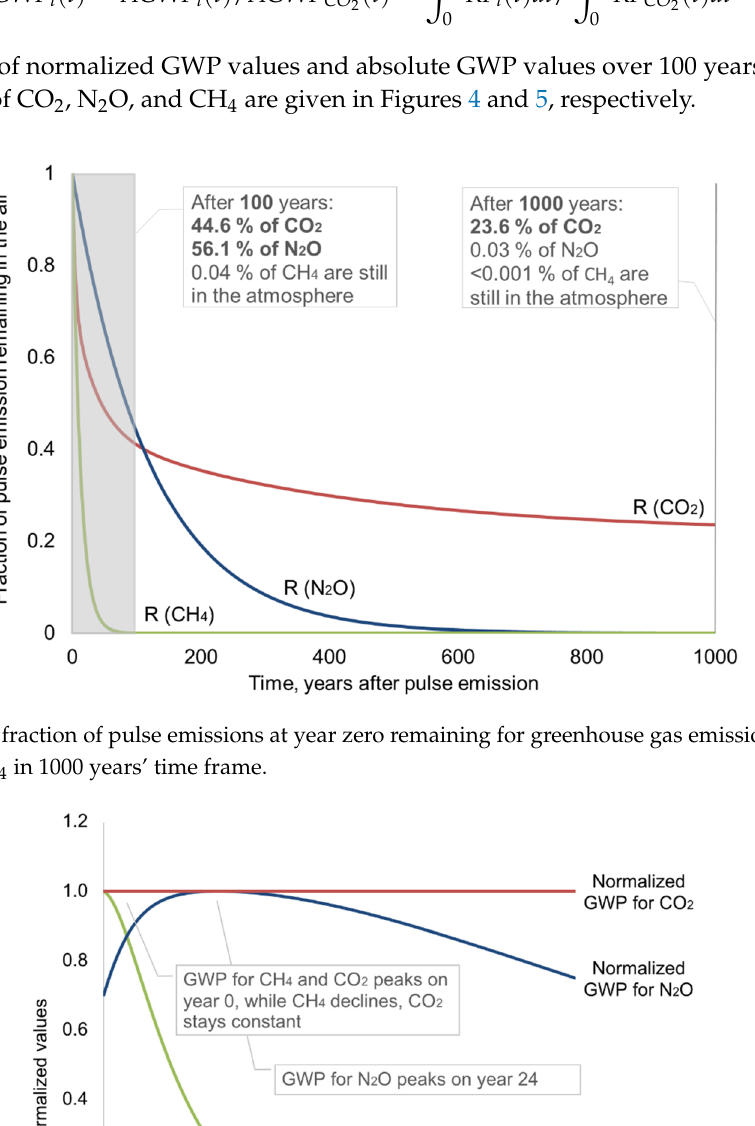
Figure 5. Absolute GWP values as a response to emission of CO 2 , N 2 O, and CH 4 at year zero, unitless. As can be seen in Figures 4 and 5, the trendlines for the emissions of CH 4 and N 2 O are both of different natures and different magnitude, while CO 2 constant values of 1 are assumed. Global temperature potential for pollutant i at time t ( GTP i ( t )) is calculated by referring absolute global temperature potential of the pollutant i ( AGTPi ), to the AGTP of the reference gas, usually CO 2 , and integrating it over time period t : (cid:1833)(cid:1846)(cid:1842) (cid:3036) ((cid:1872)) = (cid:1827)(cid:1833)(cid:1846)(cid:1842) (cid:3036) ((cid:1872)) (cid:1827)(cid:1833)(cid:1846)(cid:1842) (cid:3004)(cid:3016) (cid:3118) ((cid:1872))⁄